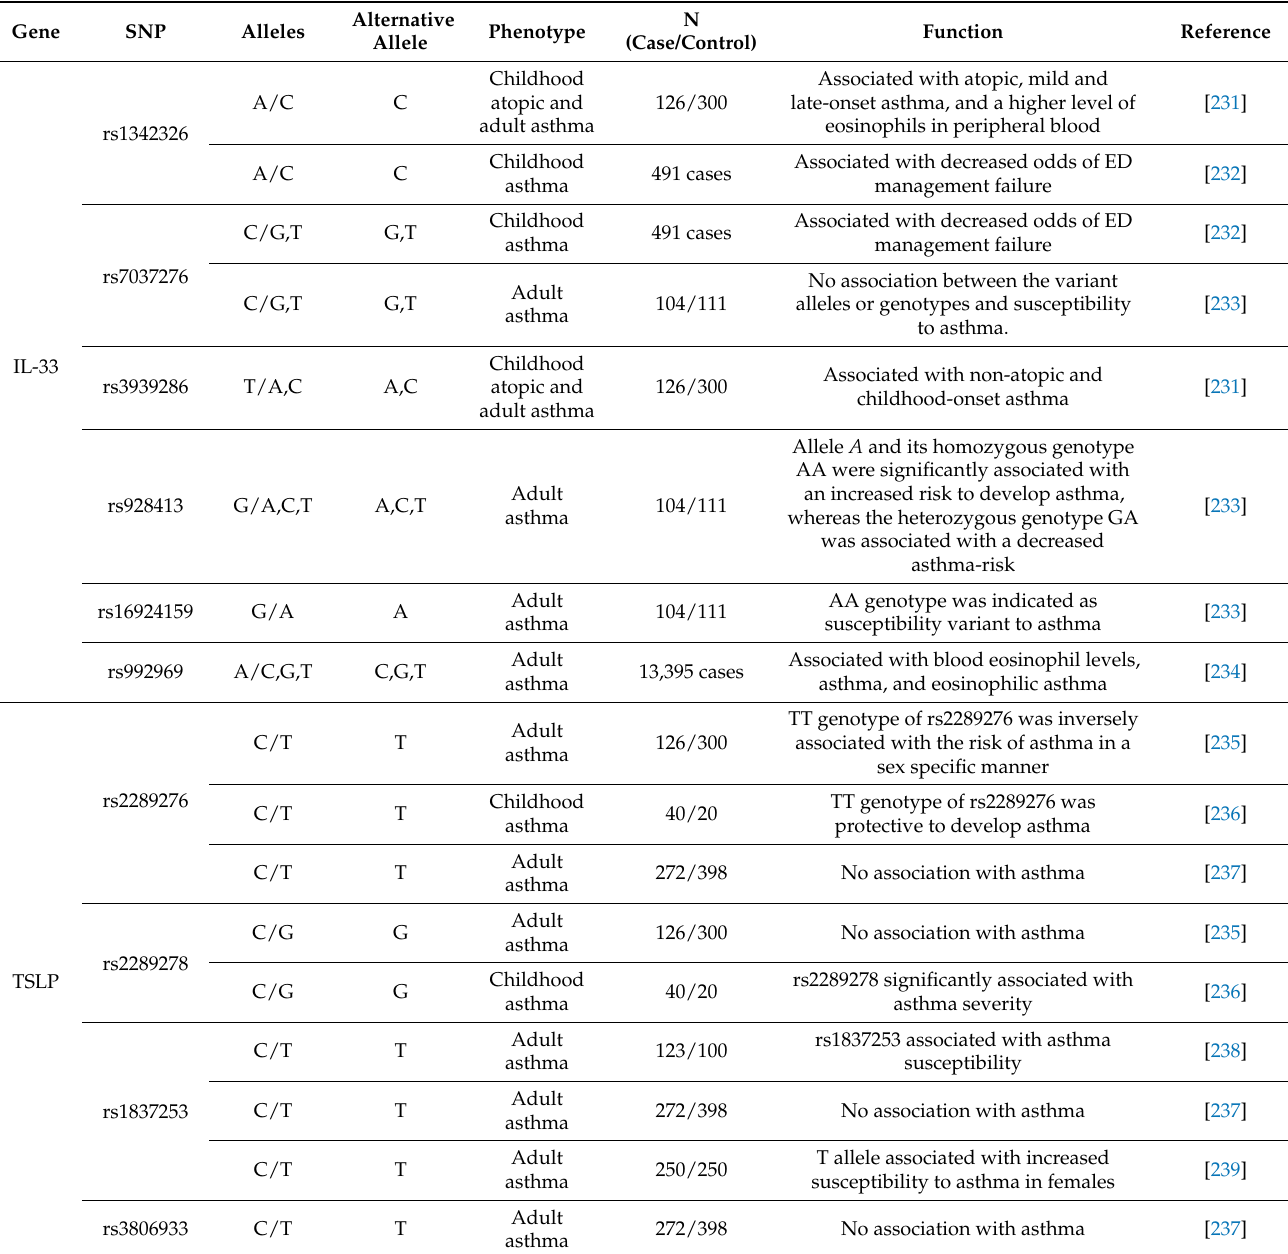
Table 4. IL-33 and TSLP SNPs and their association with